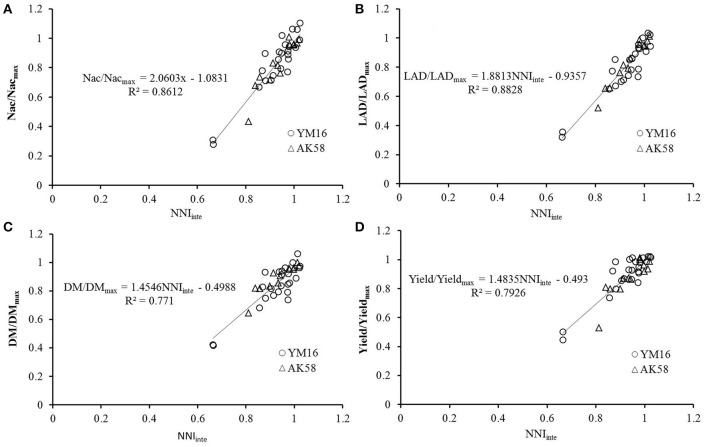
Relationships between relative growth variables and integrated nitrogen nutrition index (NNIinte). (A) Nac/Nacmax; (B) LAD/LADmax; (C) DM/DMmax; (D) yield/yieldmax.